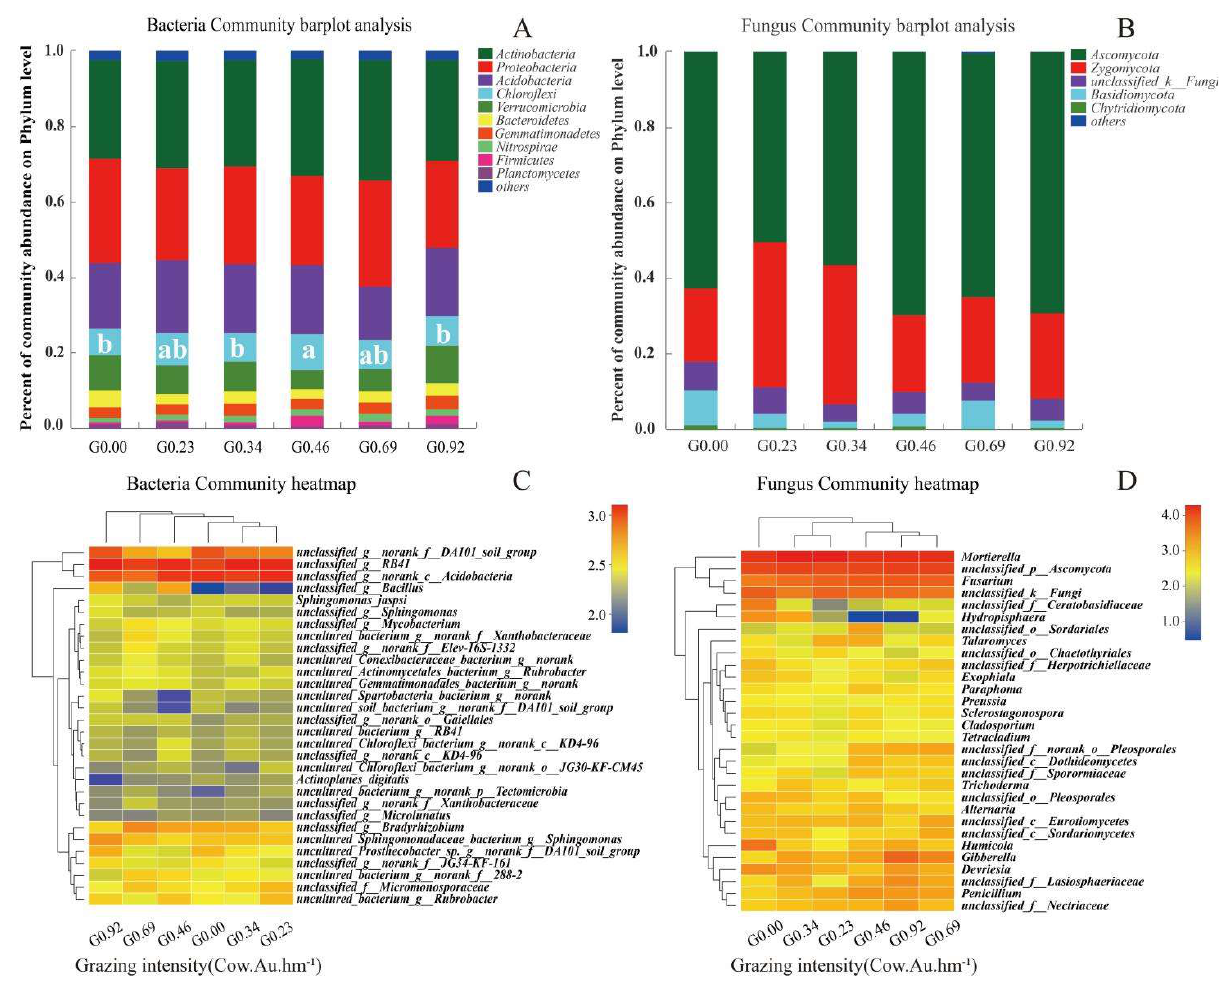
Figure 4. Relative abundance of dominant bacterial ( A ) and fungal ( B ) phyla. Heatmaps of bacteria ( C ) and fungi ( D ). In panels ( A , B ), different column colors represent different species, and the column length represents the proportion of the species. In ( C , D ), the ordinate is the species name, and the variation in abundance of different species in the sample is shown by the color gradient of the color block. Color gradients are used to represent the data values in a two-dimensional matrix or table and to present information about community species composition and species abundance. Clustering was carried out according to the similarity of the abundance between species or samples, and the results are presented in the heatmap, which groups the species with high- and low-abundance clusters in blocks and reflects the similarities and differences in the community composition of different groups (or samples) at each taxonomic level through color changes and similarity degrees. Significant differences are indicated by different